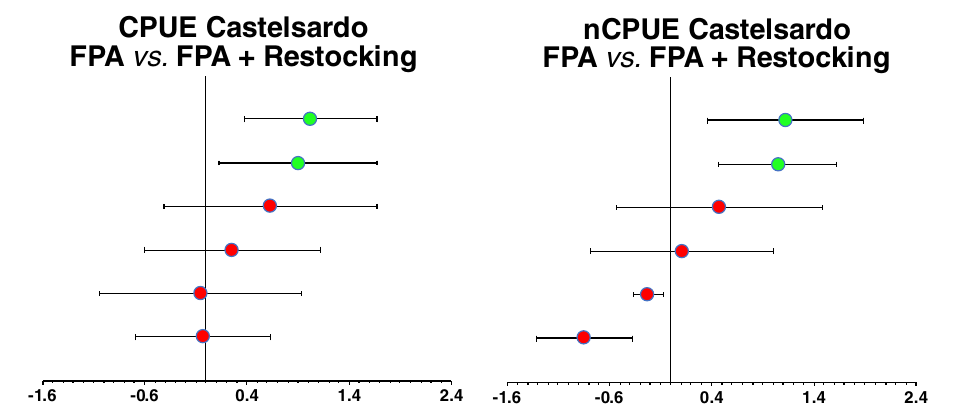
Figure 4. Forest Plot showing cumulative impacts of restocking in the two FPAs of Castelsardo (ln–response ratio; mean ± 95% confidence intervals). Red circles: non-significant ratios; green circles: significant ratios. Cumulative effects are significant if confidence intervals do not overlap